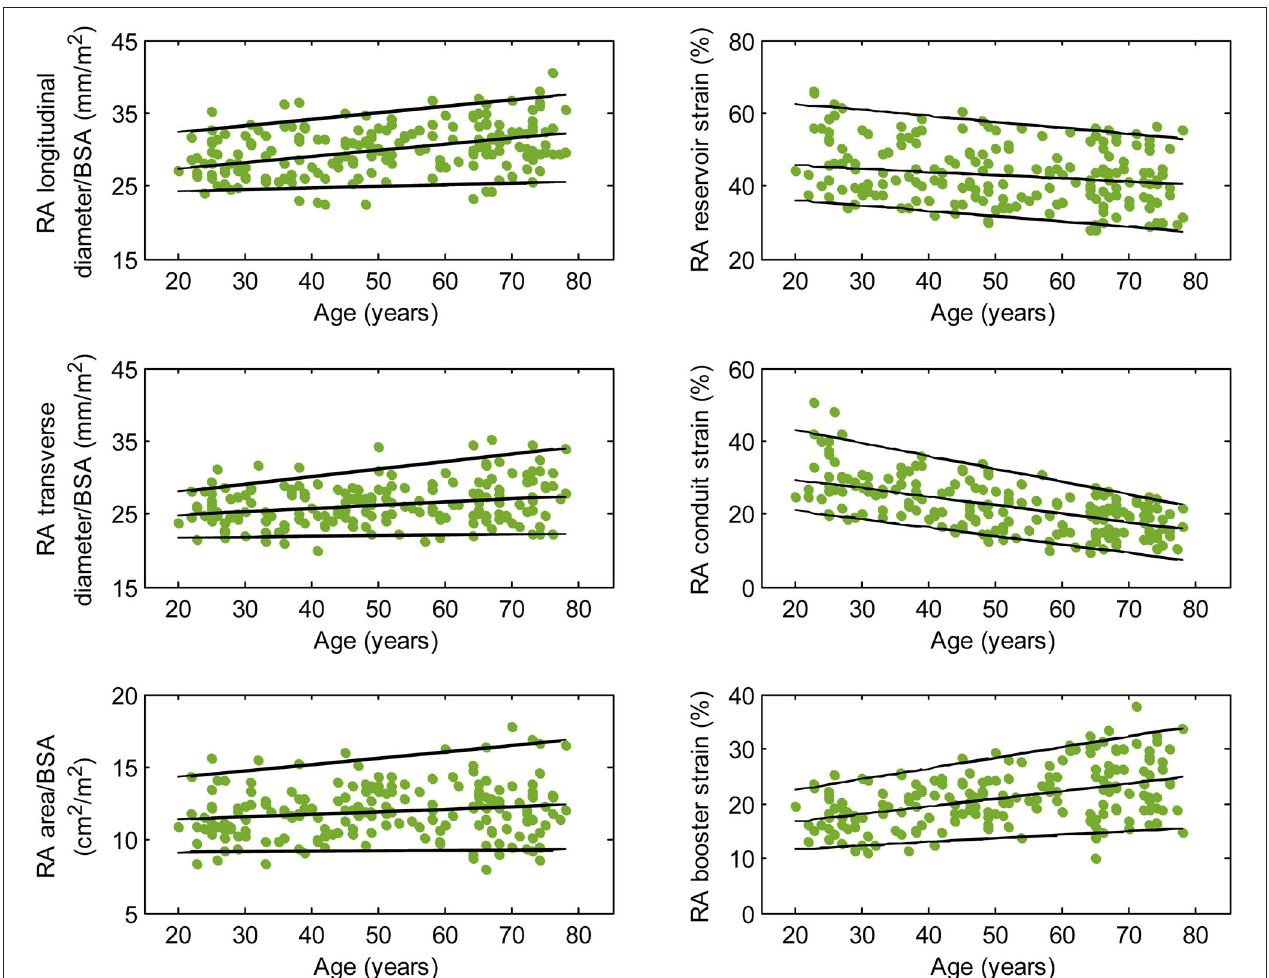
FIGURE 4 | Right atrial parameters plotted against age in male subjects. (Central line) The 50th percentile; (Top line) The 95th percentile; (Bottom line) The 5th